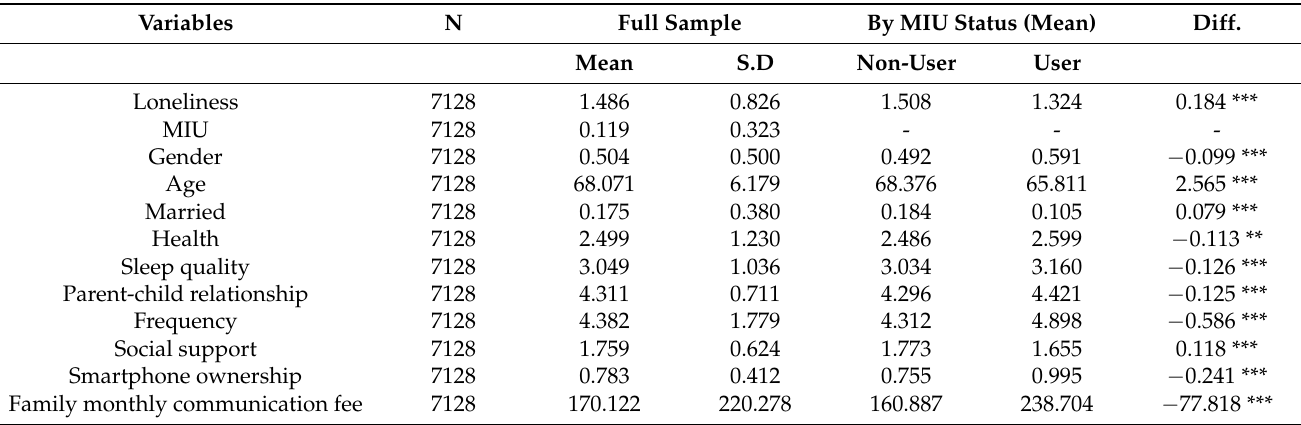
Table 1. Descriptive